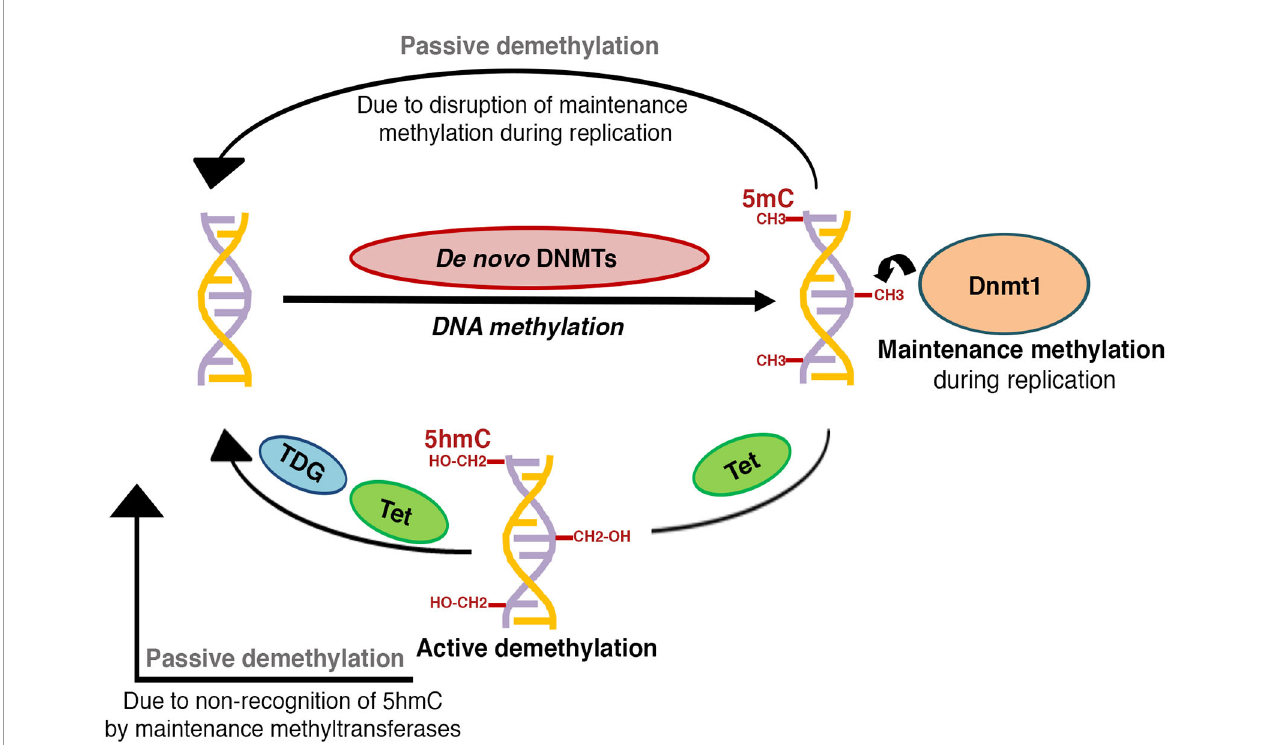
FIGURE 1 | Schematic representation of DNA methylation patterning: The establishment of new DNA methylation patterns during development is regulated by the activity of de novo DNA methyltransferases, while activity of maintenance DNA methyltransferases serves to perpetuate these patterns during successive rounds of cell division. DNA methylation marks can be reversed through active or passive demethylation. Active demethylation involves the successive enzymatic oxidation of 5-methylcytosine (5mC) to 5-hydroxymethylcytosine (5hmC),5-formylcytosine (5fC), and 5-carboxylcytosine (5caC) by TET (Ten-eleven translocation) dioxygenases, followed by thymine DNA glycosylase (TDG) dependent removal of 5fC and 5caC, coupled with base-excision repair to a cytosine (C). A hemi-methylated 5hmC is not recognized by the maintenance DNA methyltransferases and can get diluted and lost during replication, thus contributing to passive demethylation. Disruption of maintenance methyltransferase activity can similarly result in replication dependent dilution of DNA